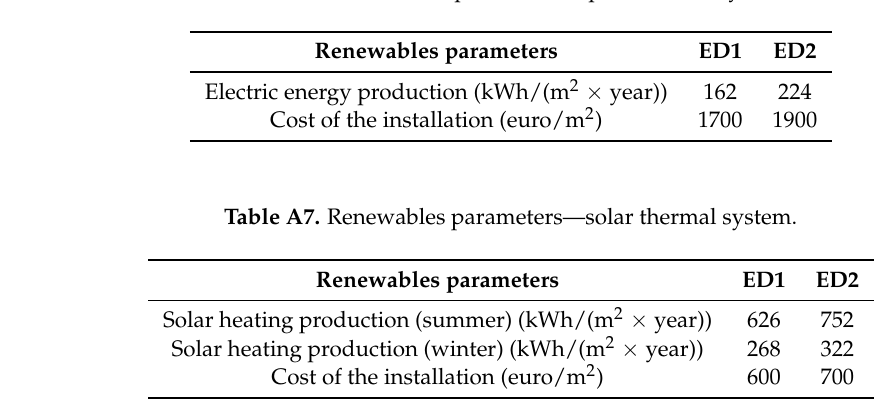
Table A6. Renewables parameters—photovoltaic system.